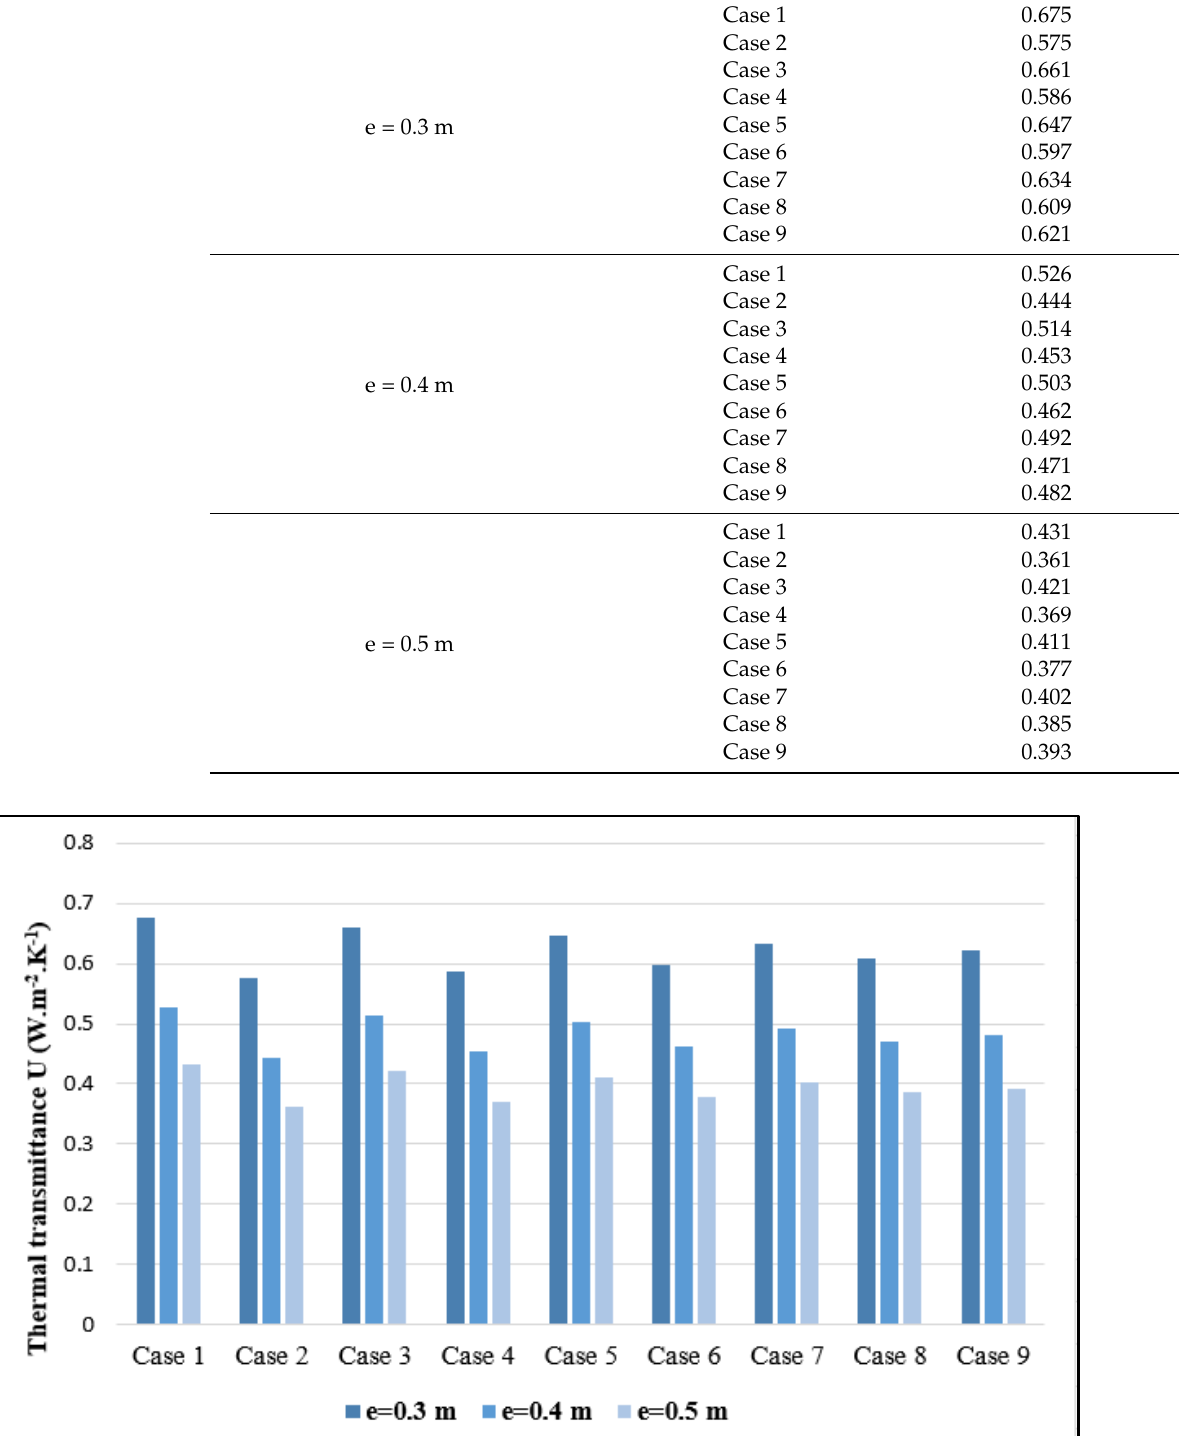
Table 5. Results of thermal transmittance of the multilayer material with the different layers. The Total Thickness of the Wall